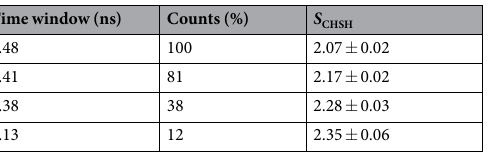
Table 1. Extracted Bell parameter from the CHSH measurements in the linear plane of the Poincaré sphere. The percentage of the correlation events taken into account for a certain time window is given in the second